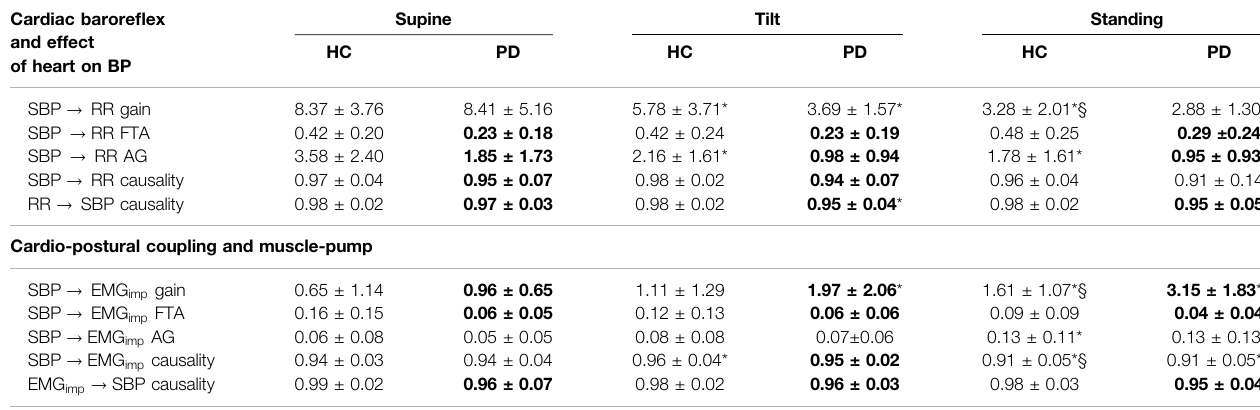
TABLE 3 | Comparison of cardiac barore fl ex, and cardio-postural coupling between healthy controls and Parkinson ’ s disease patients during supine, tilt, and standing positions. Table lists mean ± SD of gain, active gain (AG), fraction time active (FTA), and causality values. The Bolded values indicate a signi fi cant difference (Wilcoxon ranksumtest)betweenParkinson ’ spatients(PD)andhealthycontrols(HC).*,§representasigni fi cantdifference(post-hocanalysiswithBonferroniadjustment)fromsupine, tilt, respectively.